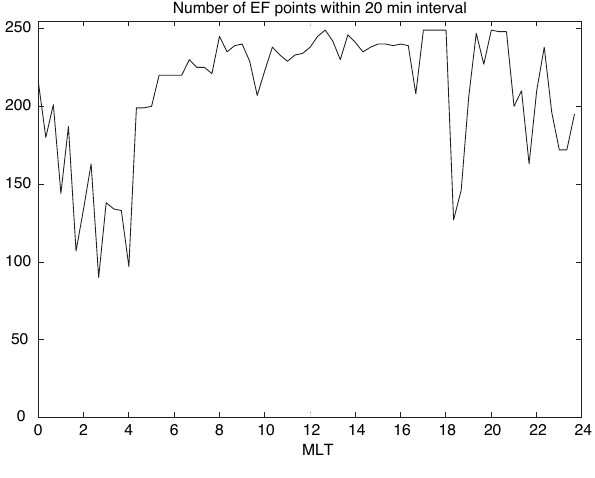
Fig. 3. Pedersen conductance: the median is shown as a black curve, and the lower and upper quartiles are shown in grey and red,